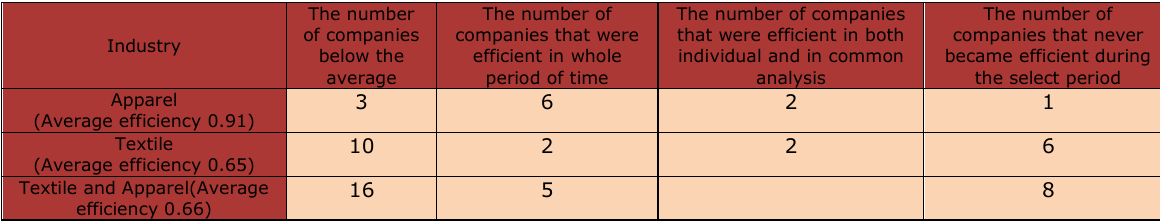
Table 2. The Overall Results of Company-Base